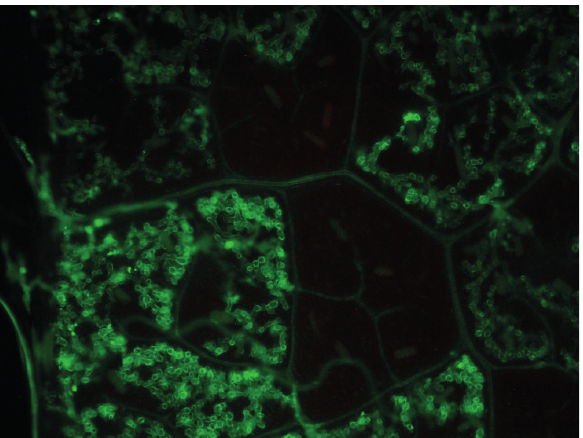
Figure 10. Symptoms caused by Plasmopara viticola on a developed cluster of grape in full